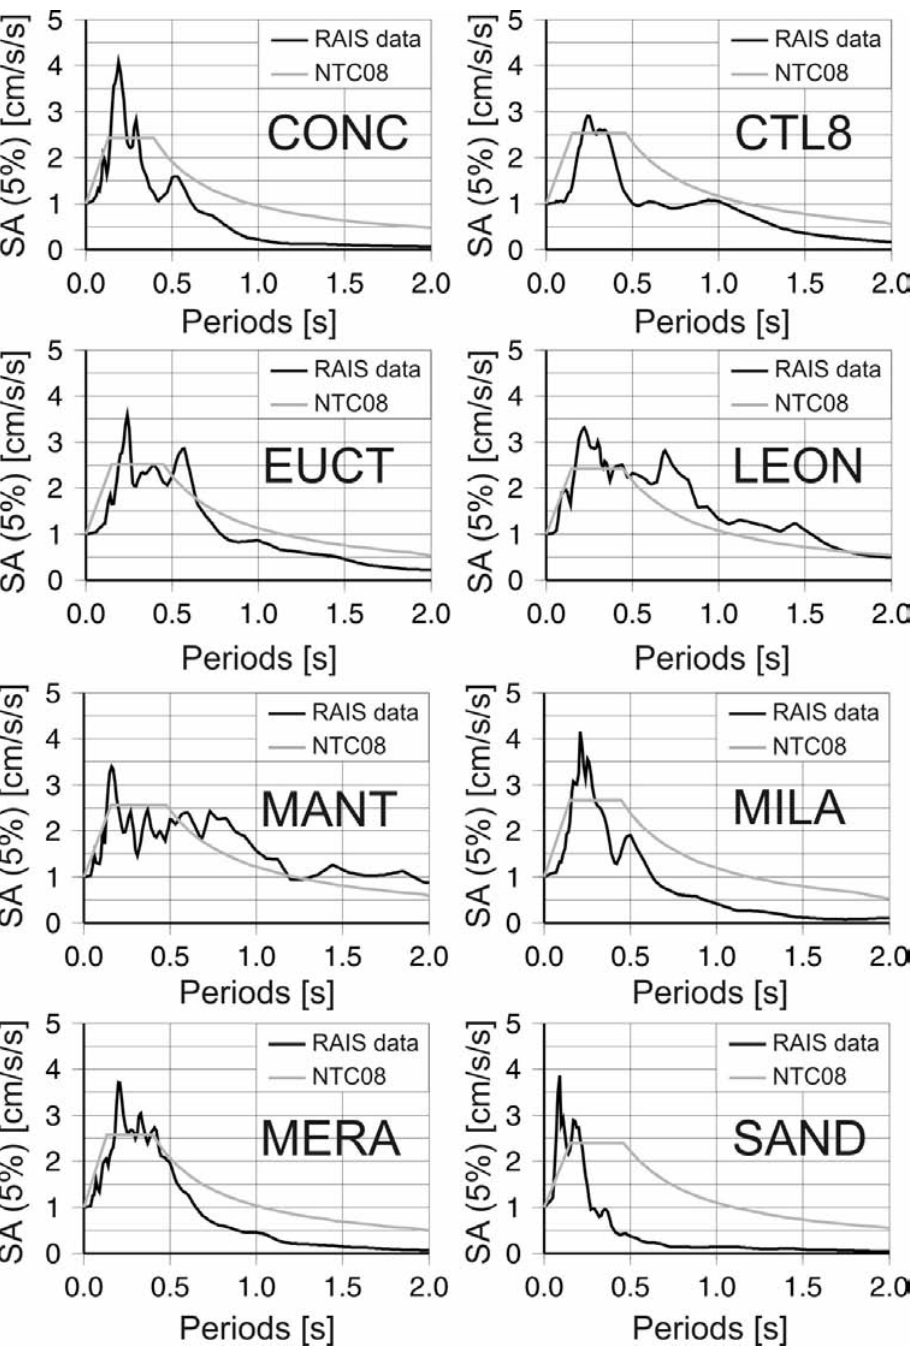
Figure 10. Comparisons between desing elastic SA as provided by the new Italian seismic code for building [NTC 2008, NTC08, gray lines] and the SA (5% damping) obtained at each station considered, from the July 17, 2011, recordings (considering the maximum horizontal component, black lines). All of the spectra were normalized considering the related values at the zero